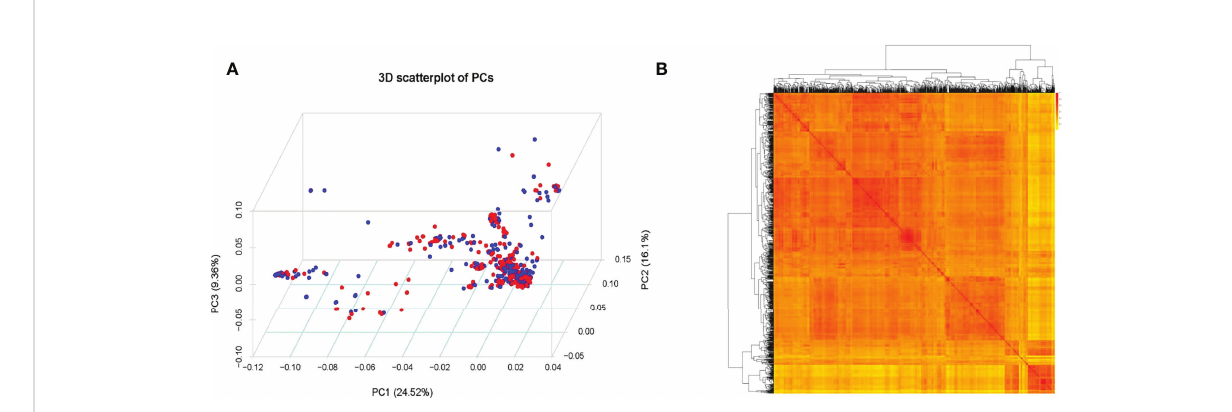
(Table S5, Figure 7C). These differentially expressed genes in